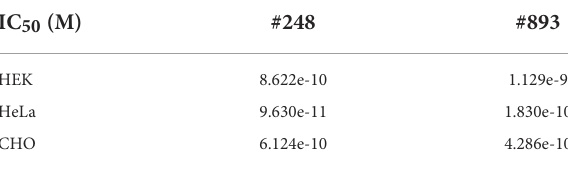
TABLE 3 IC 50 of siRNA #248 and #893 on Nox3 expression (mRNA) in the three mNox3 cell